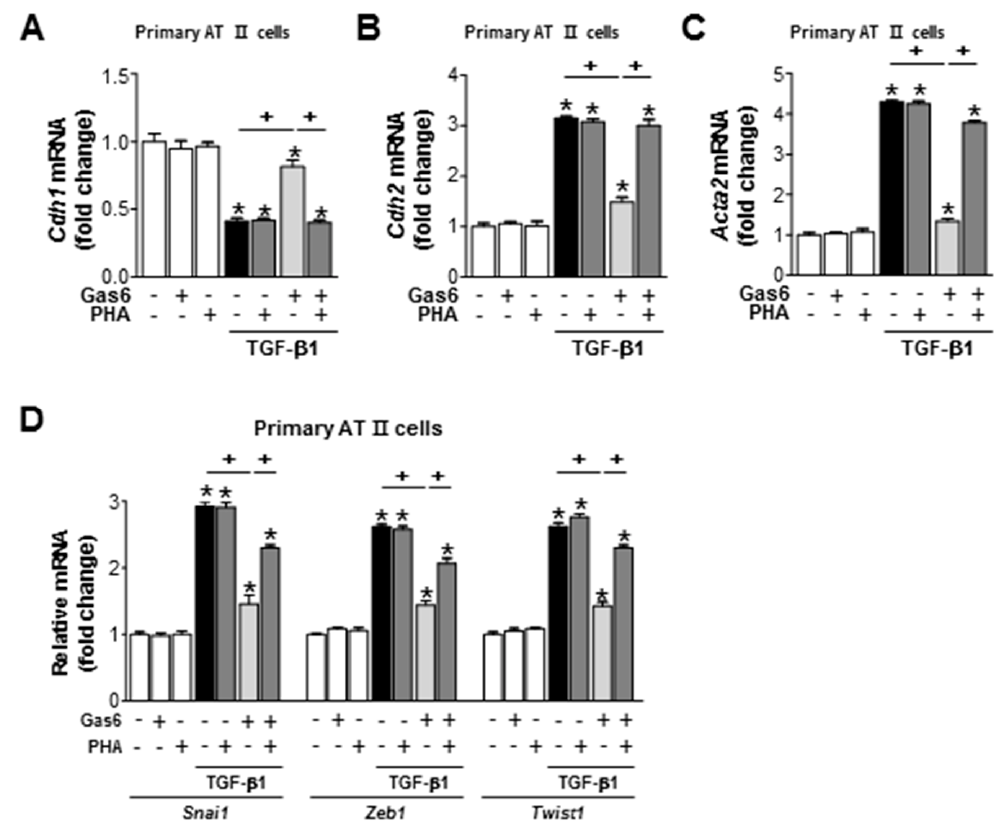
Figure 8. c-Met signaling mediates the Gas6-induced inhibition of EMT markers and EMT transcription factors in primary alveolar type II cells. Primary AT II cells were treated with 400 ng / mL Gas6 for 20 h and then stimulated with 10 ng / mL TGF- β 1 for 72 h, with or without 250 nM PHA-665752. ( A – D ) qPCR analysis of the mRNA levels of EMT markers and EMT-inducing transcription factors. Values represent the mean ± SEM of three independent experiments * p < 0.05 compared with control; + p < 0.05, as indicated.